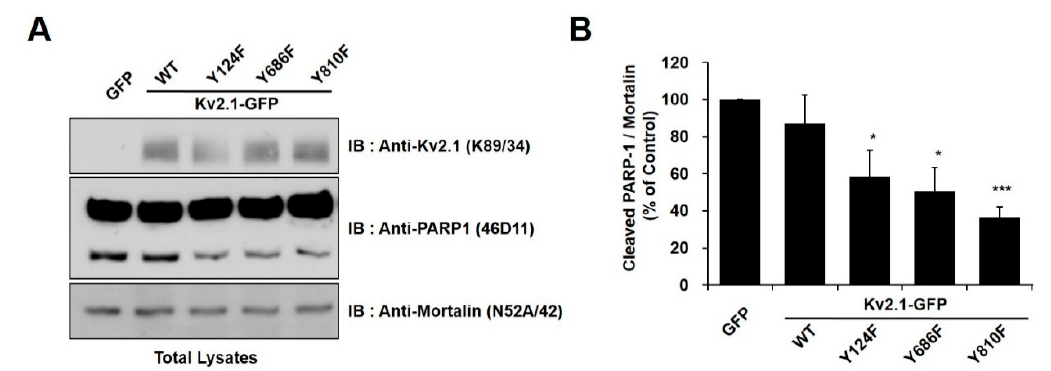
Figure 2. Tyrosine mutations of the K v 2.1 channel decreased apoptotic cell death in DTDP-treated cells. ( A ) Immunoblot analysis of PARP-1 cleavage in HEK293 cells expressing K v 2.1-WT or the mutations after DTDP treatment. The full-length PARP-1 (116 kDa) and the fragmented PARP-1 (89 kDa) apoptotic cleaved product as well as mortalin, which was used as a loading control. ( B ) Compared with K v 2.1-WT, DTDP treatment decreased cleaved PARP-1 expression in cells containing the K v 2.1 channel tyrosine mutations. Data are expressed as the mean ± S.E.M. (* p < 0.05, *** p < 0.01, Student’s t test).